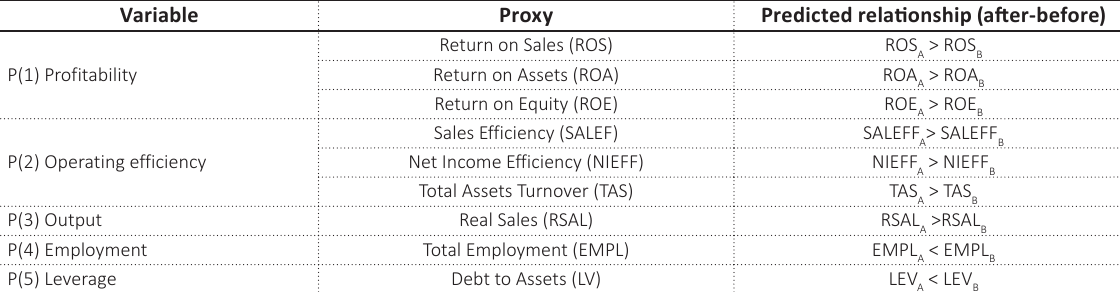
Table 1. Summary of testable mean predictions for privatized SOEs with tax incentives